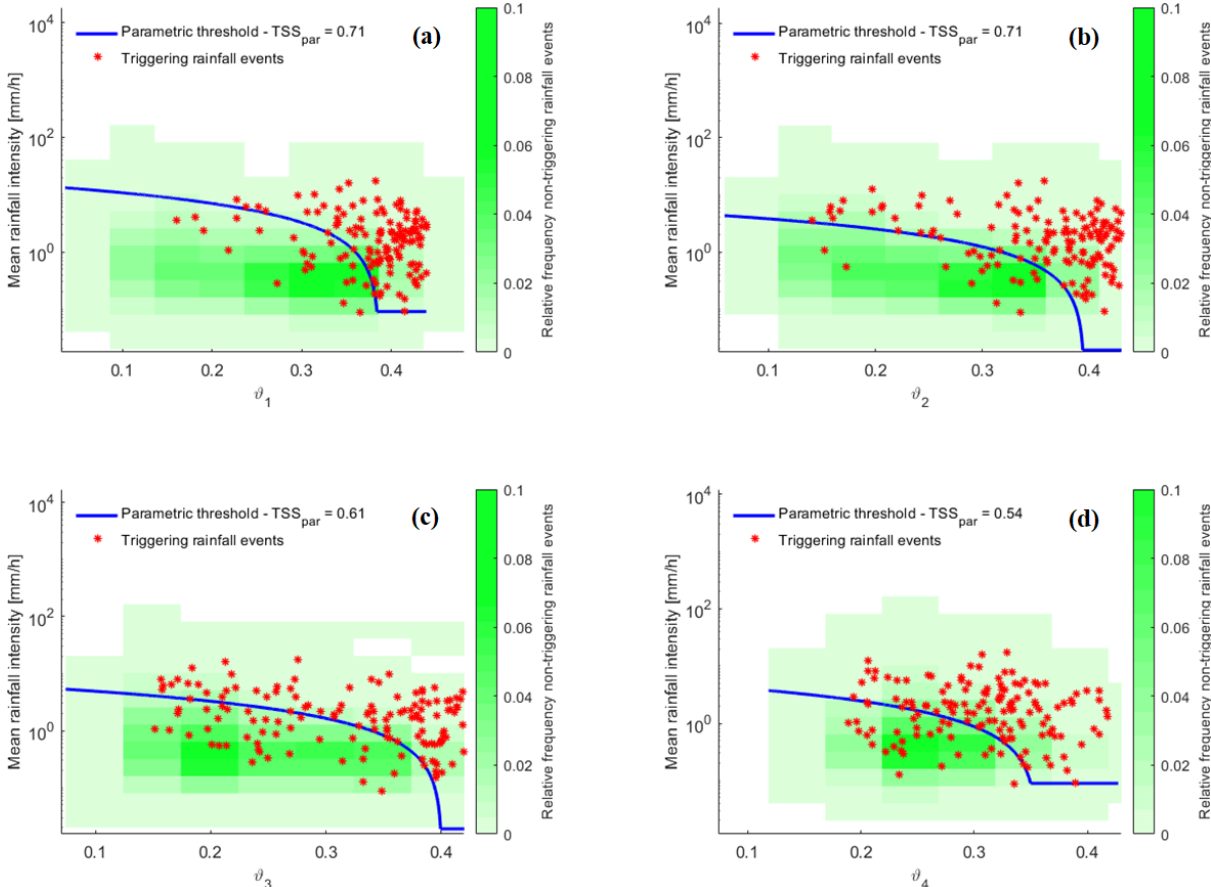
Figure 8. Parametric thresholds on the semi-log plane between mean rainfall intensity and soil moisture at the four distinct depths: (a) ϑ 1 0–7cm; (b) ϑ 2 7–28cm; (c) ϑ 3 28–100cm; (d) ϑ 4